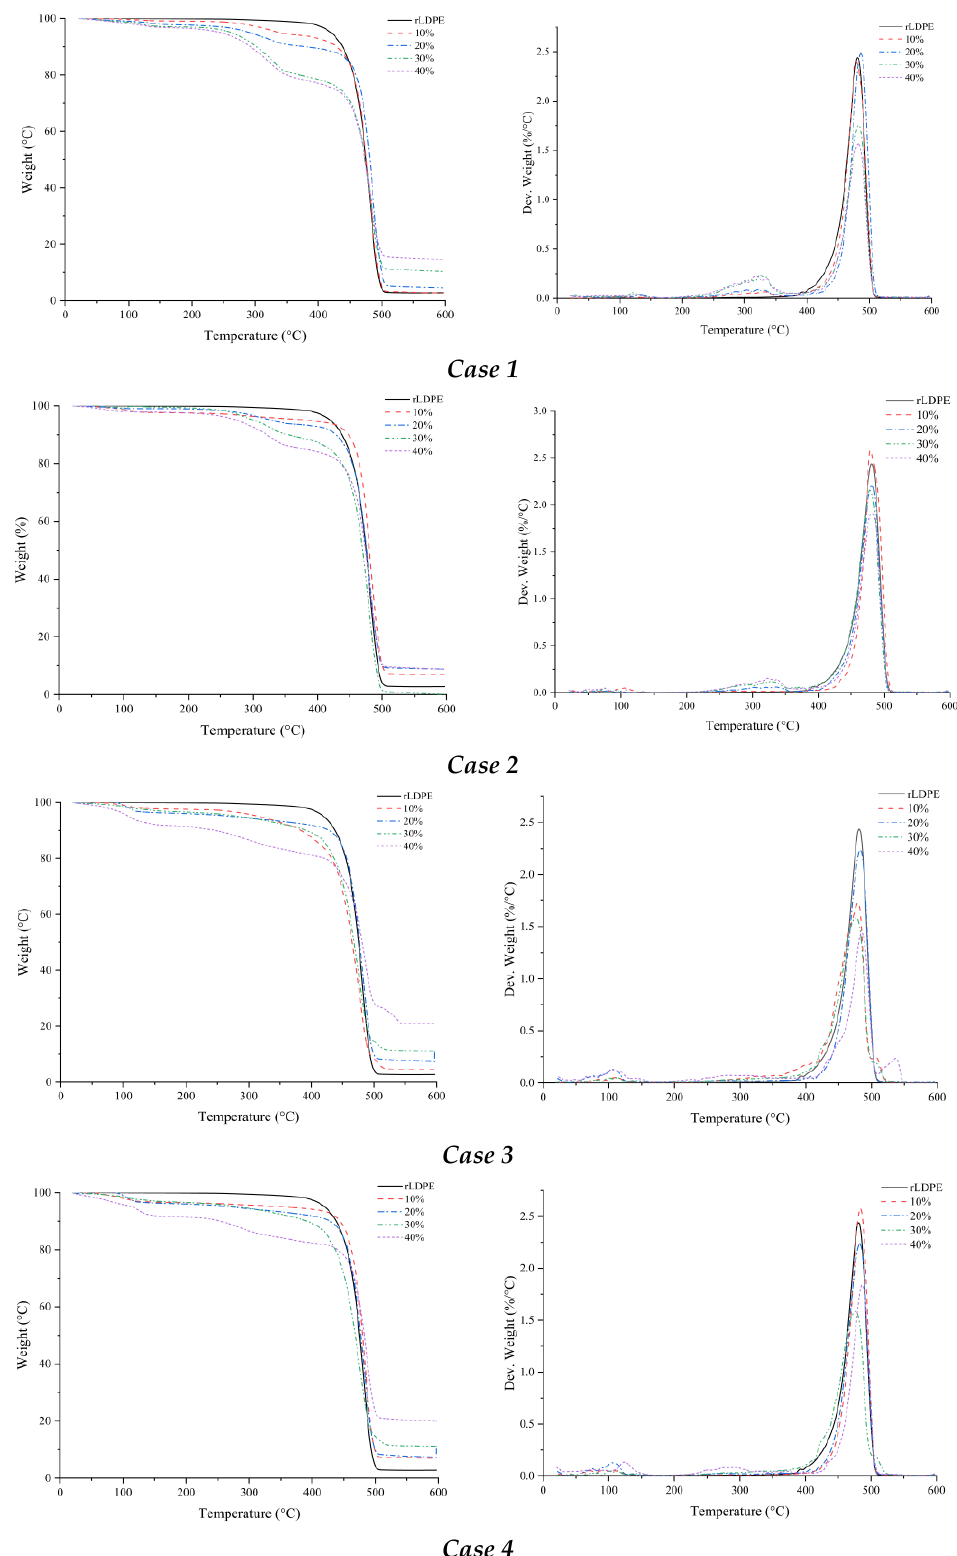
Figure 11. Comparison of TGA/DTG curves of the developed biocomposites with rLDPE.